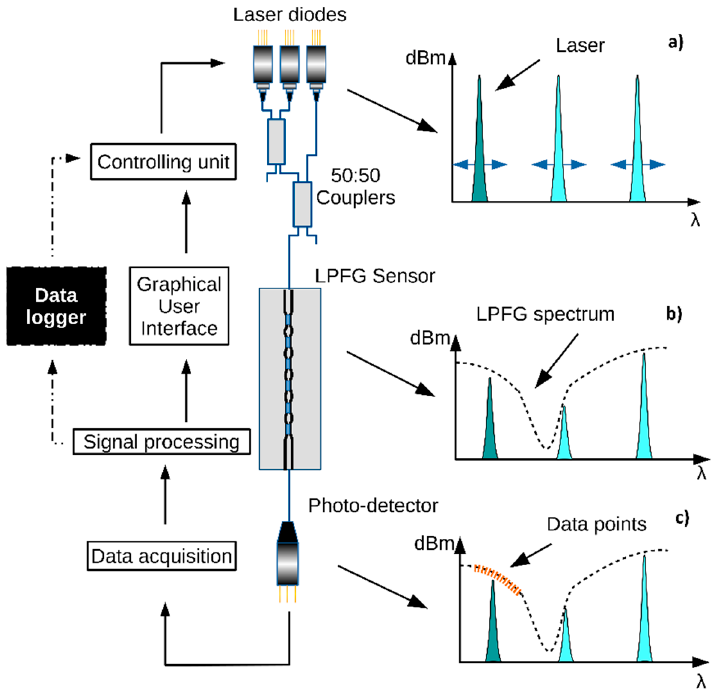
Figure 1. Interrogation methodology description and signal-flow. ( a ) Laser diodes being thermally swept. ( b ) Long-period fiber grating (LPFG) spectrum changing the transmitted optical power. ( c ) Data acquisition by the photo-detector for the laser diode that was turned ON.